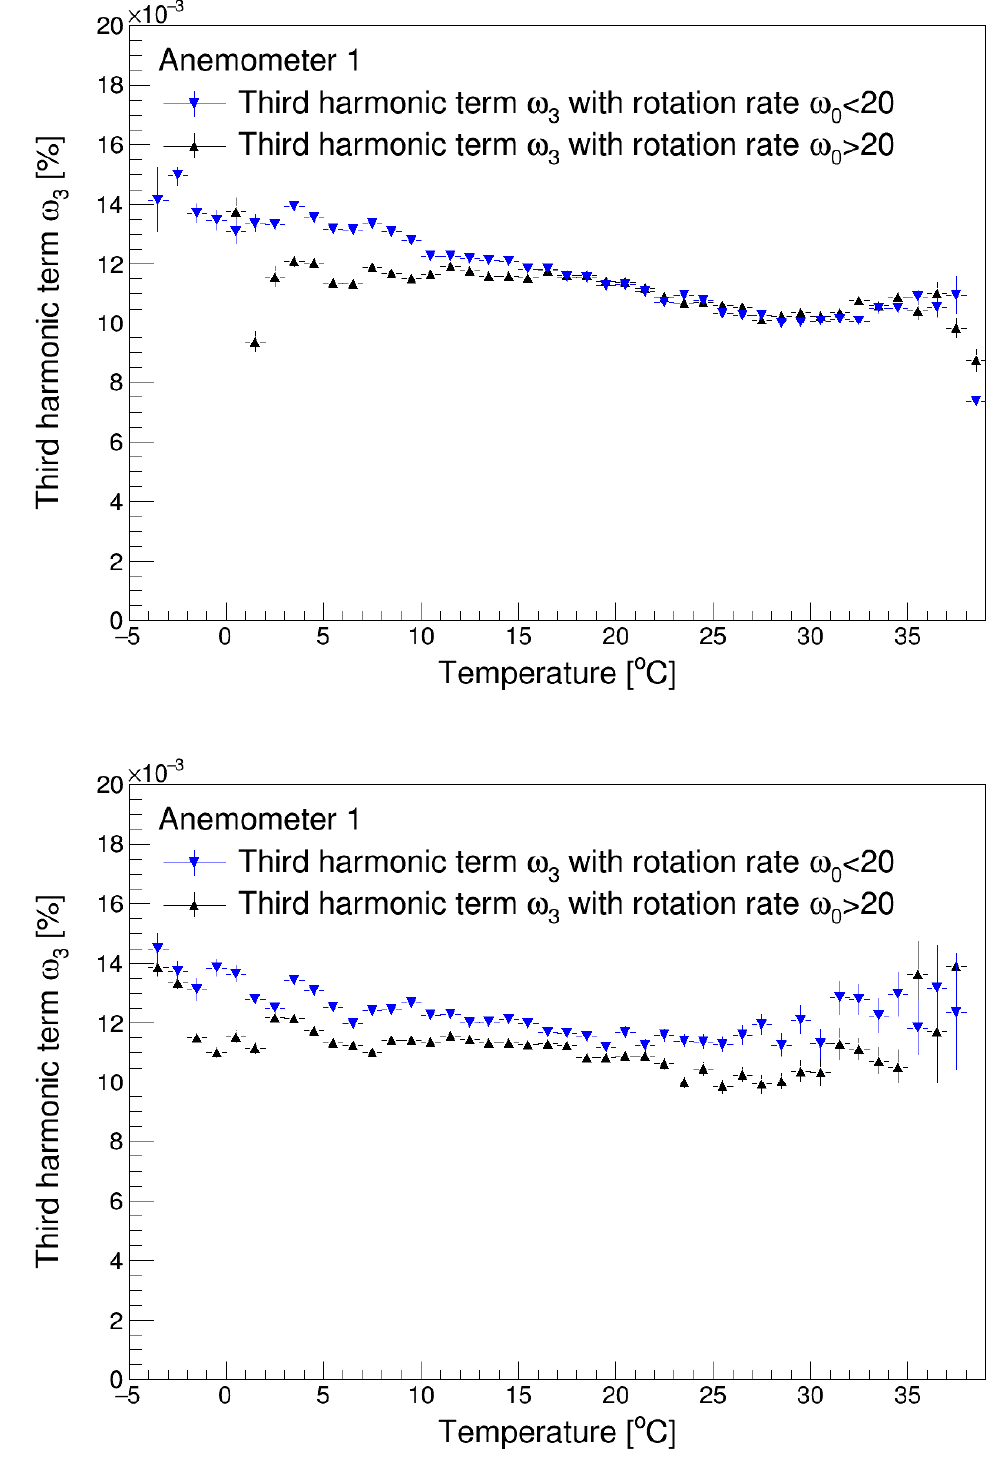
Figure 8. Third harmonic terms of Anemometer 1 ( top ) and Anemometer 2 ( bottom ) as a function of temperature.